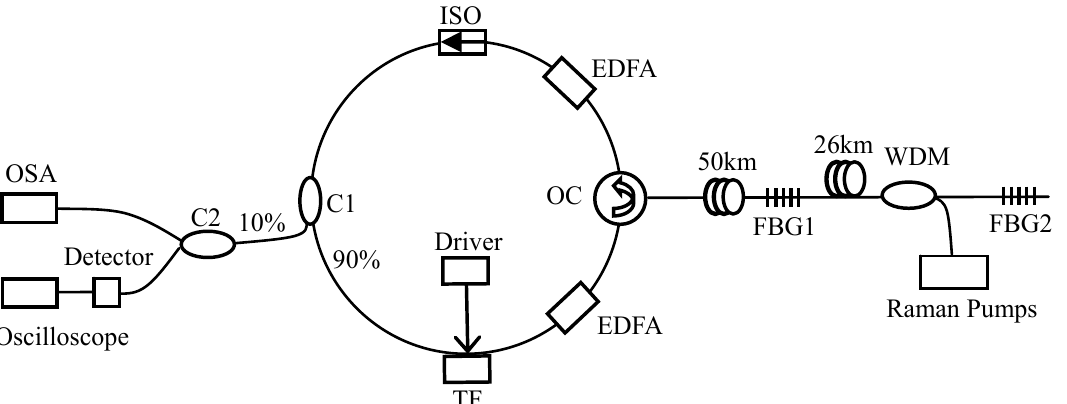
Figure 10. Setup of the ultra-long-distance FBG sensor system based on an SL-FDML fiber